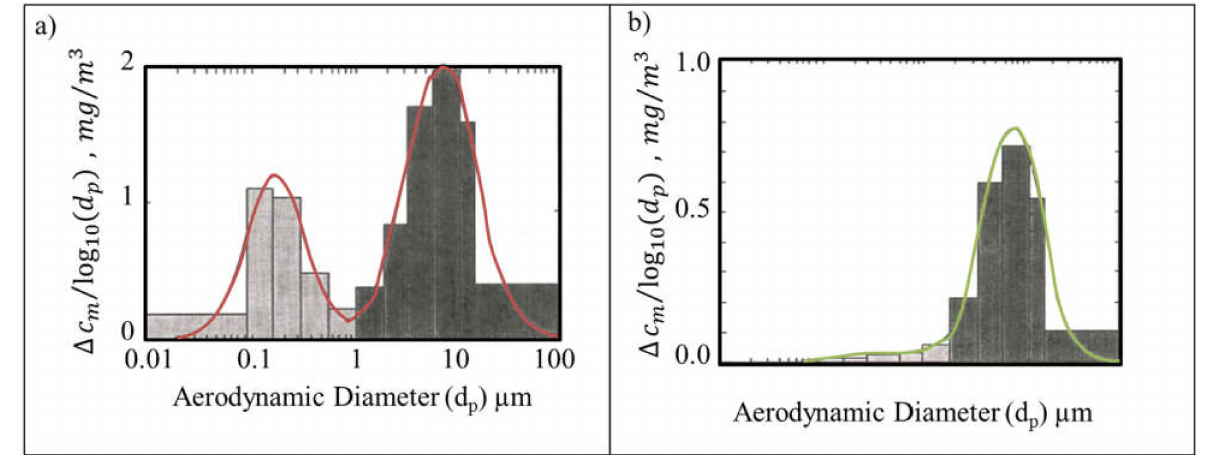
Figure 5. Mass-based size distribution measured by MOUDI at ( a ) a coal mine with diesel equipment, and ( b ) a coal mine with all electric equipment